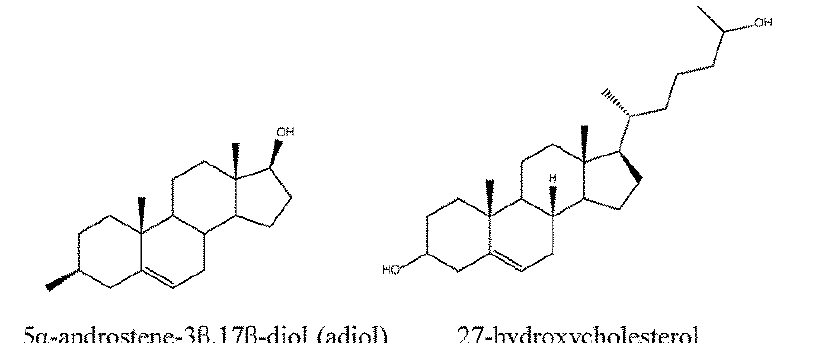
Figure 7. Other endogenous ligands of the ERs, 5α-androstene-3β,17β-diol (adiol) and 27-hydroxycholesterol (27OH).